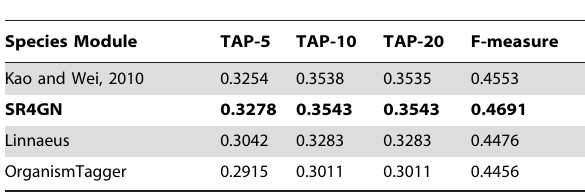
Table 3. Evaluation using the test data from the BioCreative III GN task.